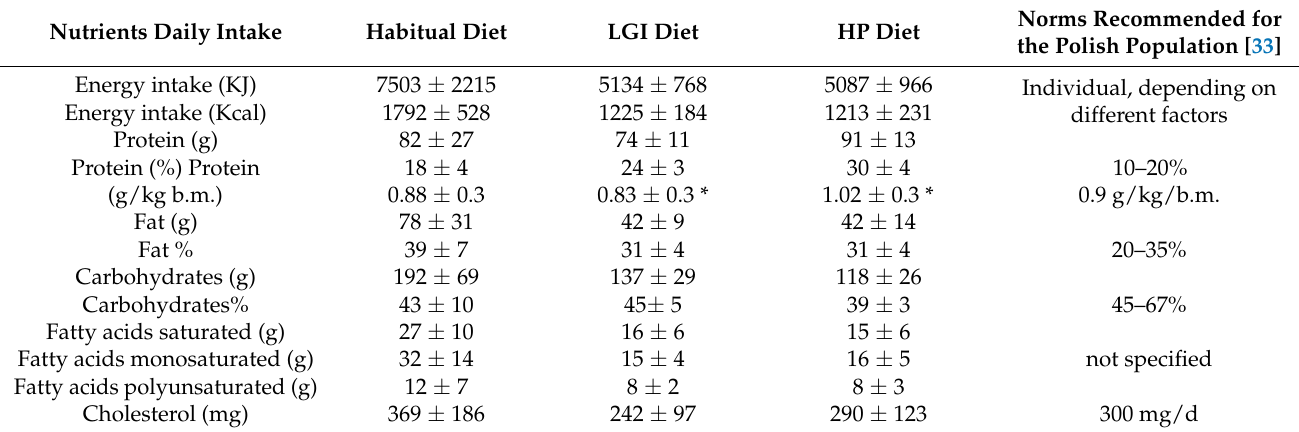
Table 2. The mean dietary macronutrient composition of the habitual diets at baseline and of the energy-restricted LGI and HP diets (based on the food